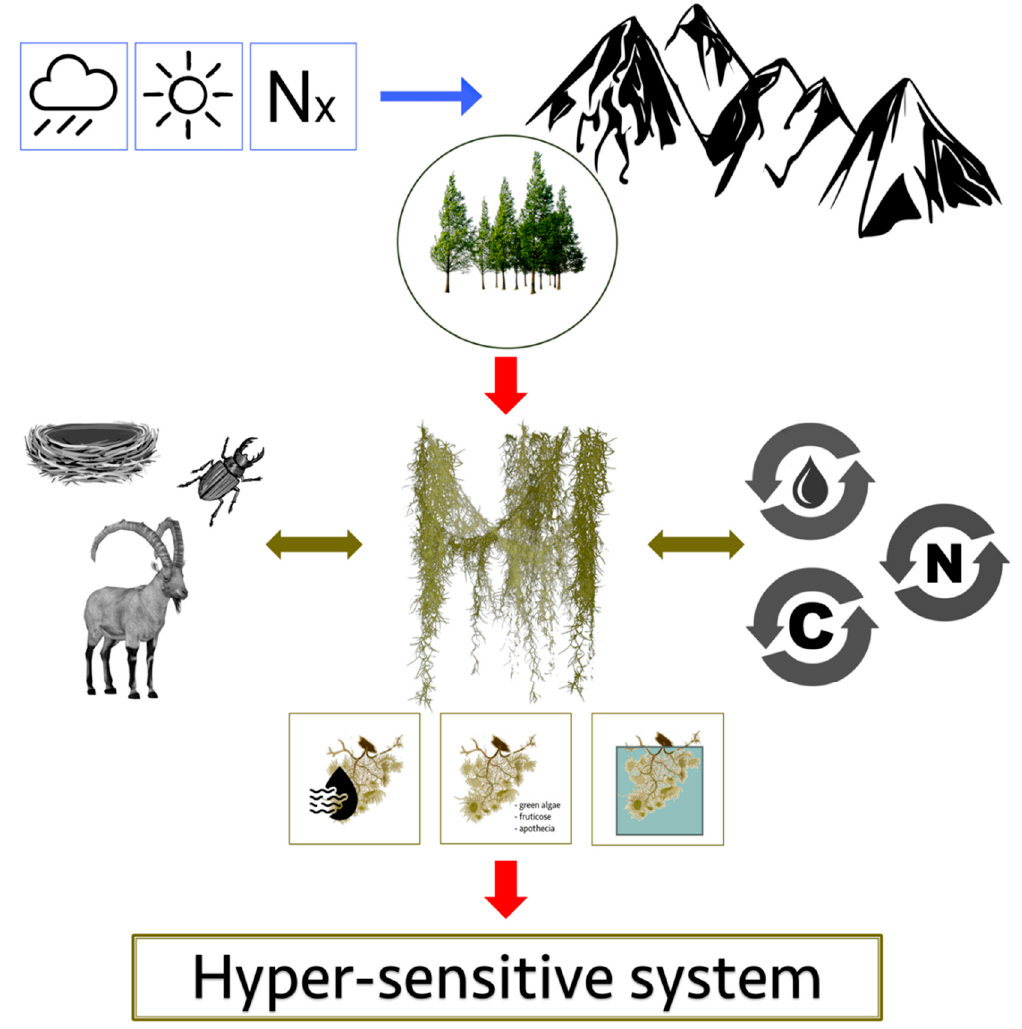
Figure 1. Conceptualization of the role and potential of hair-lichens as ecological indicators in high-elevation forests. Blue squares represent the variations in precipitation, global warming, and atmospheric deposition of reactive nitrogen (blue arrow), which are the main factors of global change threatening high-elevation ecosystems. The green arrows represent the ecological roles of hair-lichens that contribute to forest ecosystem functioning in sustaining habitat quality and resilience. The green squares on the left represent the poikylohydric nature of lichens; in the center is their main functional traits and on the right the high surface area is exposed to the atmosphere, which provides a basis for considering hair-lichens among the most sensitive organisms to high-elevation environments. The scheme stresses their potential for the early detection of the effects of climate change and air pollution.